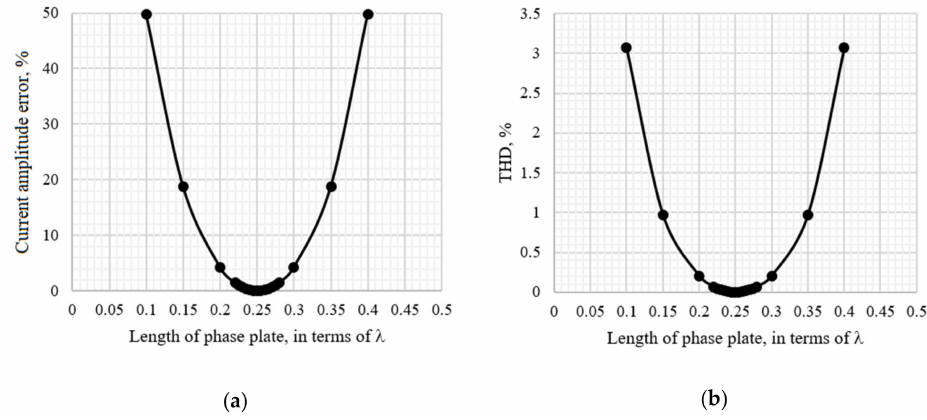
Figure 18. Dependences: ( a ) Current amplitude error vs. length of phase plate; ( b ) Total harmonic distortion (on the right) vs. length of phase plate.